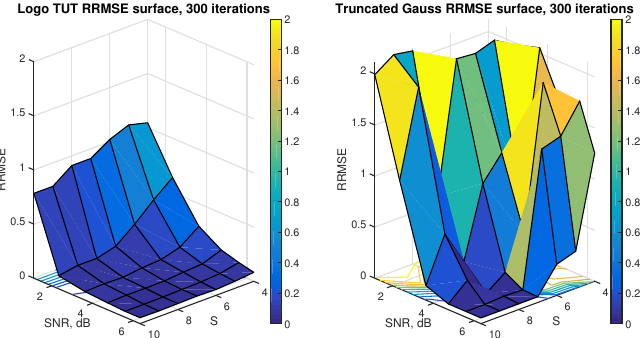
Figure 4. RRMSEs as functions of SNR and the number of experiments S , 300 iterations, left and right 3D images are for Logo TUT and truncated Gaussian, respectively.